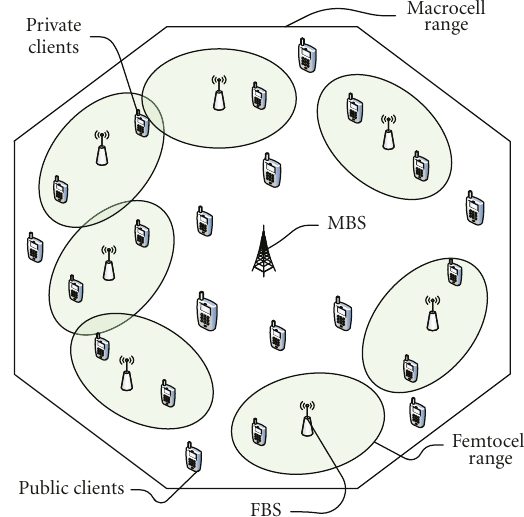
Figure 3: Cognitive femtocell network architecture. The architec- ture is composed of a single MBS with several FBSs Each FBS controls its power to reduce interference caused to neighbour FBSs and also to the